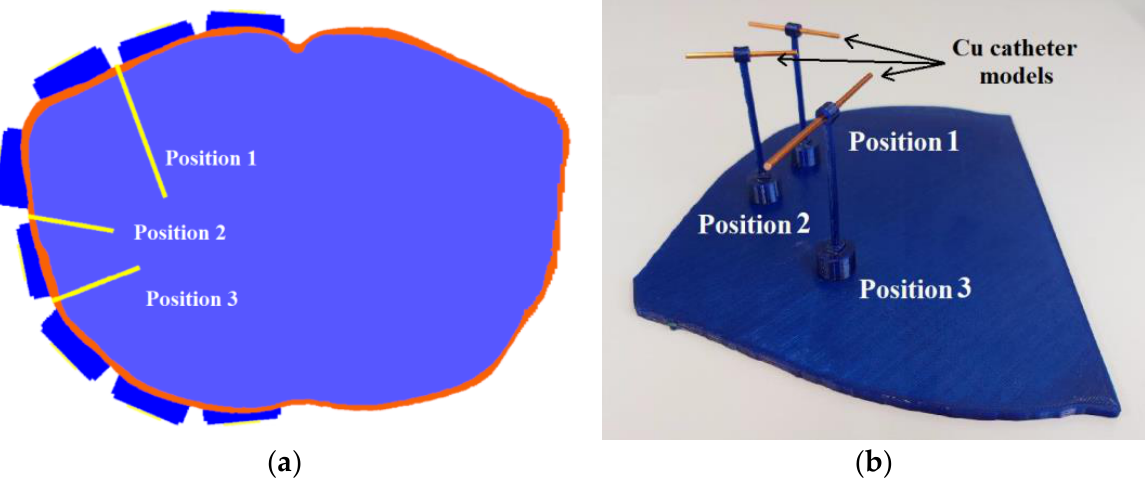
( c ) Figure 10. Experimental model: ( a ) Antenna holder; ( b ) Description of individual parts of the exper- imental model; ( c ) Assembled experimental model with placed antennas. Further, we designed a holder to insert three catheters on the predefined positions, see Figure 11a. A designed positional model ensured the exact catheter positions within the experimental model. This model was designed for accurate and repeatable placement